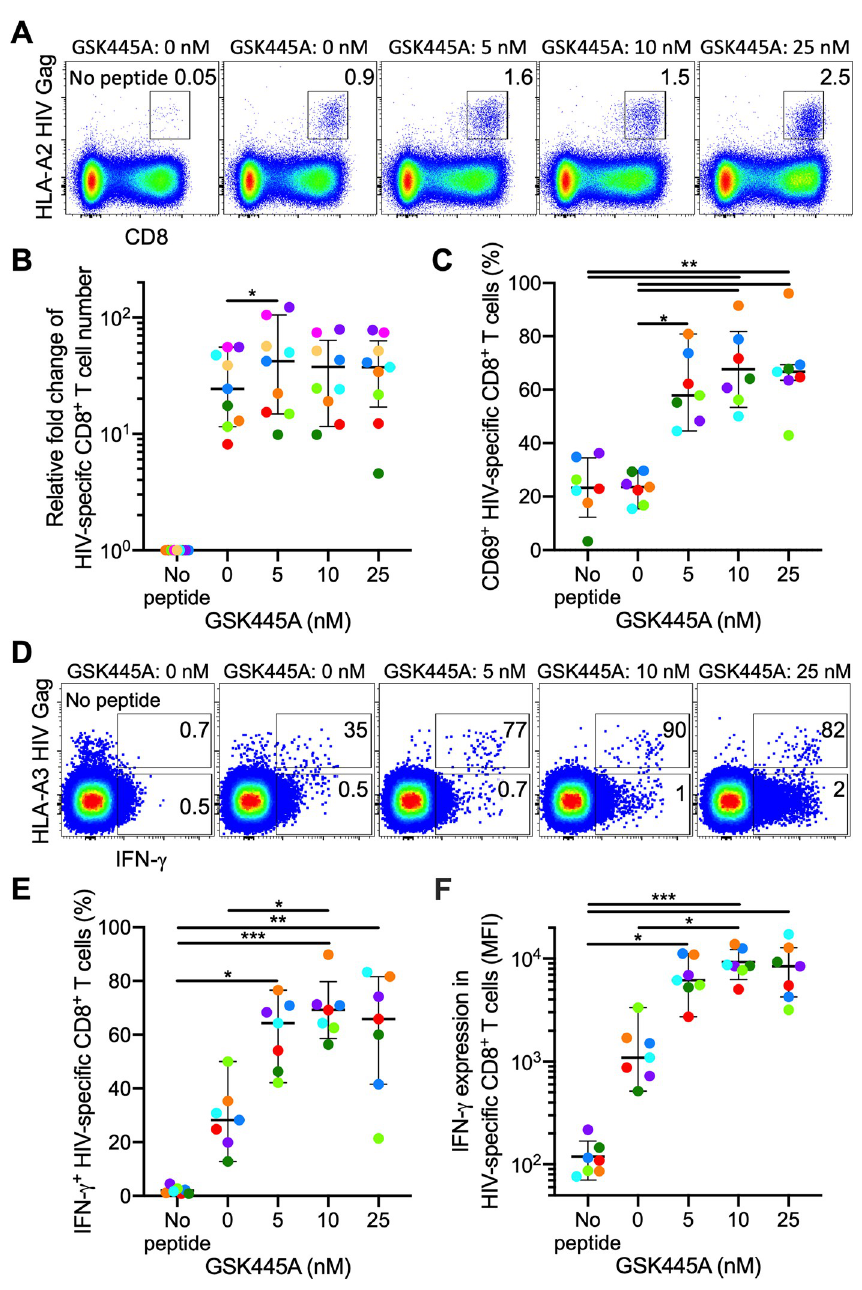
Fig 3. GSK445A synergistically enhances IFN- γ production in HIV-specific CD8 + T cells upon antigen stimulation. (A) Representative HLA-A0201 HIV Gag tetramer staining after 6 days of A2-Gag-FK10 peptide stimulation with prior 30 minutes GSK445A pulse. Percentage of tetramer + CD8 + T cells in total CD8 + T cells is shown. (B) Fold change of HIV-specific CD8 + T cell numbers relative to the cells cultured without peptide and prior GSK445A pulse (No peptide) from 9 PWH are shown. (C) CD69 expression on HIV-specific CD8 + T cells from 7 PWH after 6 hours of the peptide stimulation with prior GSK445A pulse. (D) Representative expression of IFN- γ in HLA-A0301 tetramer + HIV-specific CD8 + T cells or total CD8 + T cells after 6 hours of peptide stimulation. Percentage of IFN- γ + cells within HIV-specific CD8 + T cells or total CD8 + T cells are shown. (E) Percentage of IFN- γ + cells and (F) expression levels of IFN- γ (MFI) within HIV-specific CD8 + T cells from 7 PWH. Differences among conditions were analyzed with Friedman test followed by Dunn’s Multiple Comparisons test. � P < 0.05; �� P < 0.01; ��� P < 0.001.